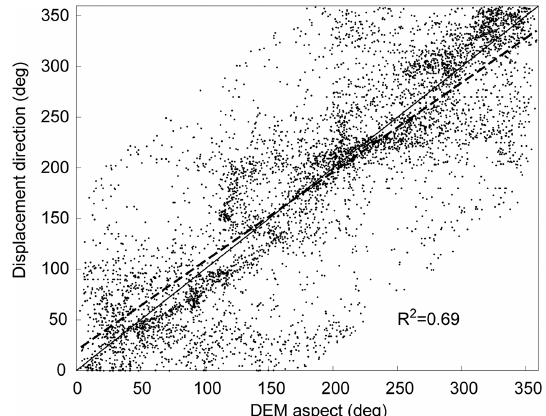
Figure A4. Displacement direction vs. DEM aspect on middle and northern circles (fine domains and gravel rings). Trend indicated by dashed line ( R 2 = 0.69). The missing data in the corners are due to the ambiguity in differences that occur at the transition from 359 to 360 ◦ = 0 ◦ . Differences larger than 180 ◦ have been subtracted from 360 ◦ to arrive at angles smaller than 180 ◦